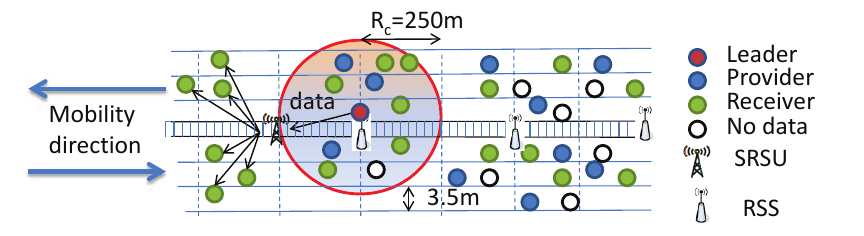
Figure 4. Data uploading to and downloading from the smart road side unit